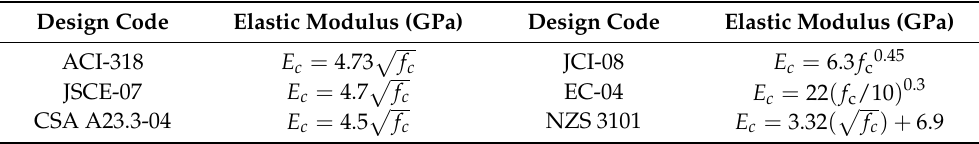
Table 4. The design code expressions and empirical models for estimating the elastic modulus based on the compressive